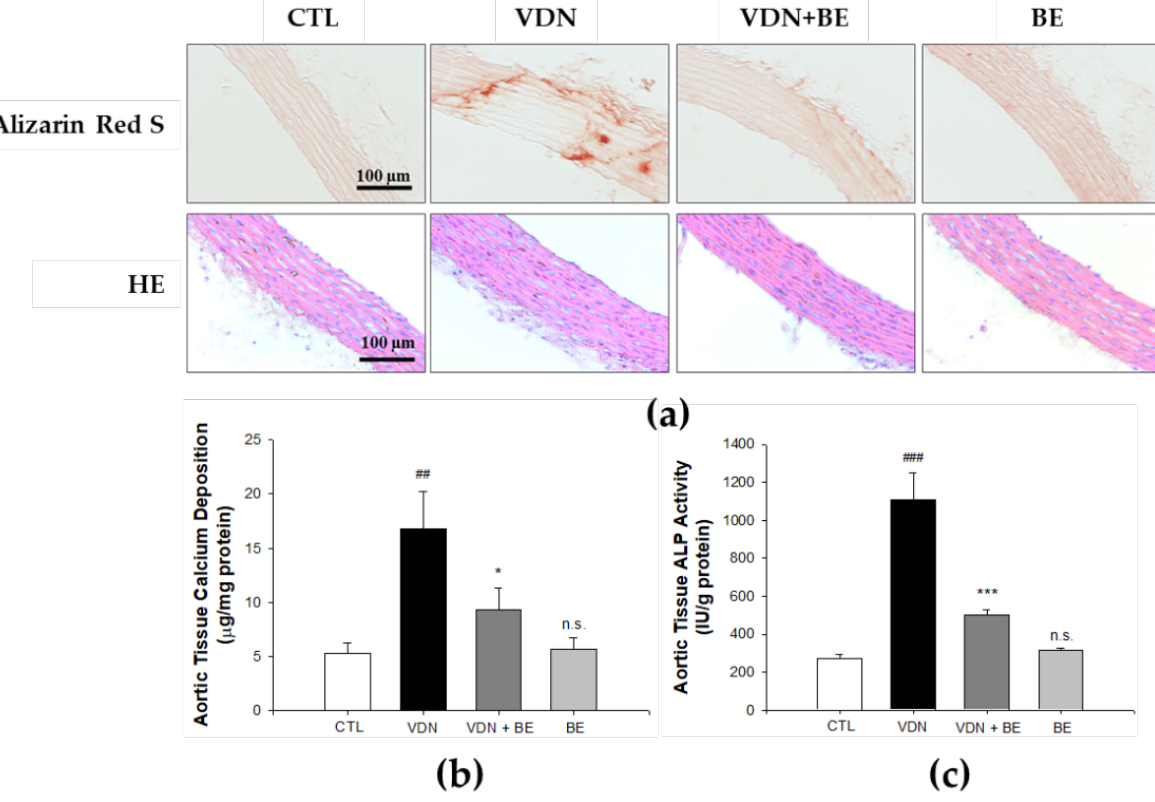
Figure 2. Baicalein reduces calcium deposition and downgrades ALP activity in thoracic aorta of SD rats. ( a ) The aortic calcium content examined by Alizarin red S staining. ( b ) Quantification the calcium level and ( c ) ALP activity in the thoracic aorta homogenates of SD rats. Scale bar indicates 100 µ m. All values are presented as mean ± SEM from four independent experiments. ## p < 0.01; ### p < 0.001 vs. control group; * p < 0.05; *** p < 0.001 vs. the VDN group; n.s. mean not significant vs. control group.